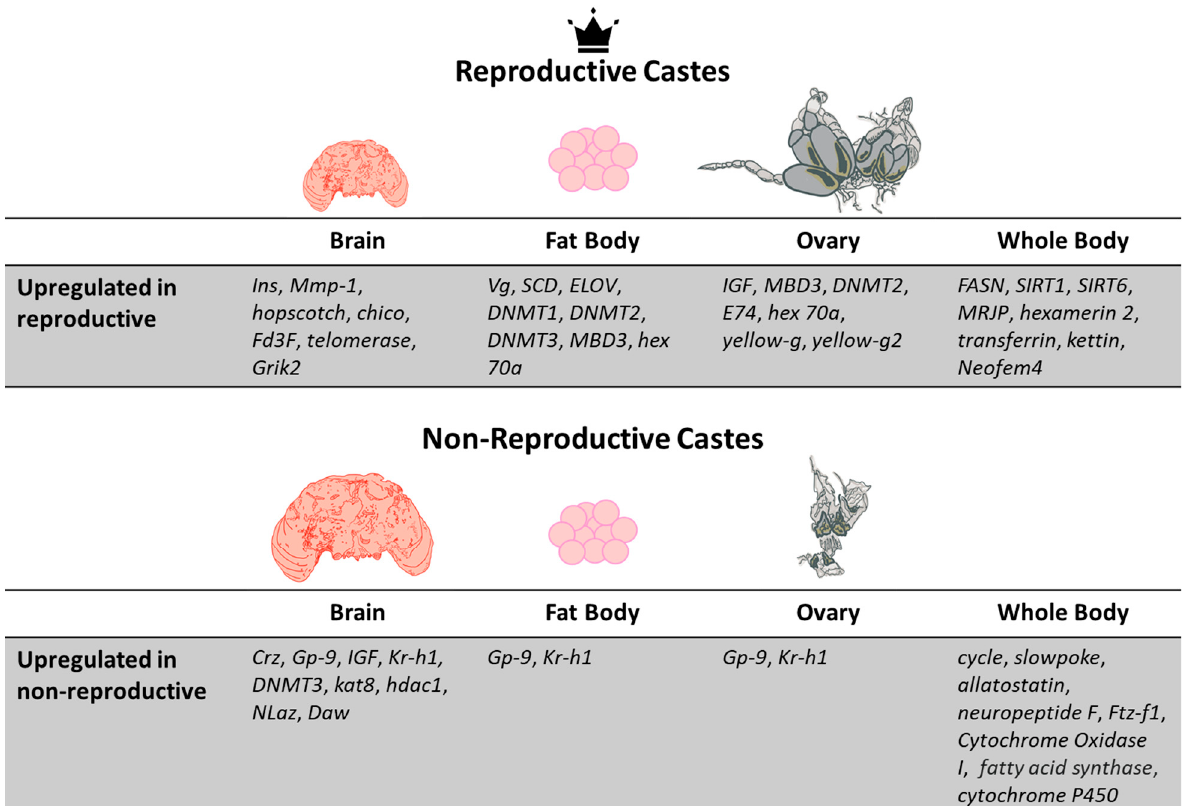
Figure 2. A summary of the upregulated genes and structural changes occurring in three different tissue types (the brain, fat body, and ovary) in reproductive and non-reproductive castes. Additionally, genes found to be upregulated in transcriptome analyses of whole insect bodies are also included. Non-reproductive females possess larger brains and inactivated ovaries, while reproductive females generally experience a reduced brain size, but much larger activated ovaries. Representative genes from all major eusocial insect lineages are listed here, including genes from ants [31–34,37,73,74], bees [75–80], social wasps [81,82], and termites [72].